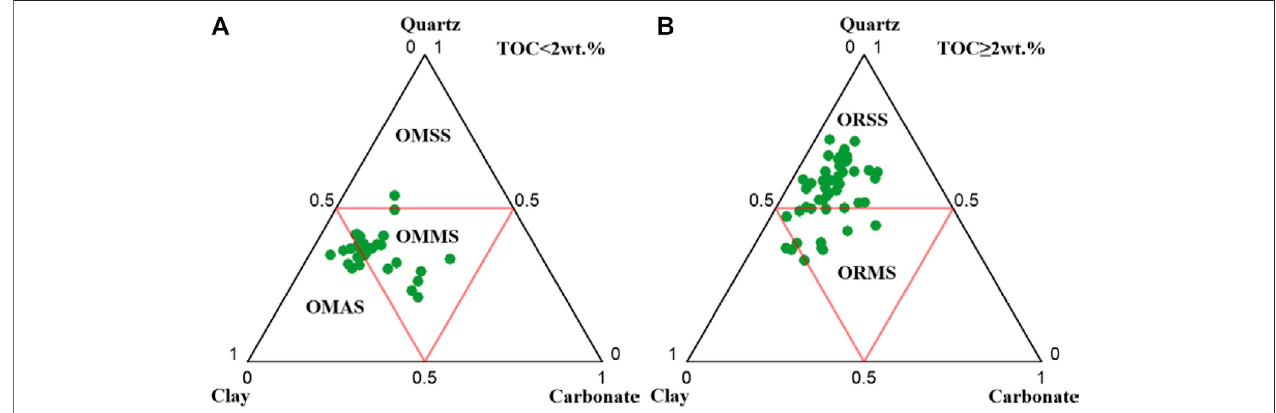
FIGURE 3 | Lithofacies classi fi cation based on TOC content and ternary diagram of mineralogy of shale samples. (A) Ternary diagram for samples with TOC ≥ 2%. (B) Ternary diagram for samples with TOC < 2%. ORSS: Organic-rich siliceous shale; ORMS: Organic-rich mixed shale; OMMS: Organic-moderate mixed shale; OMAS: Organic-moderate argillaceous